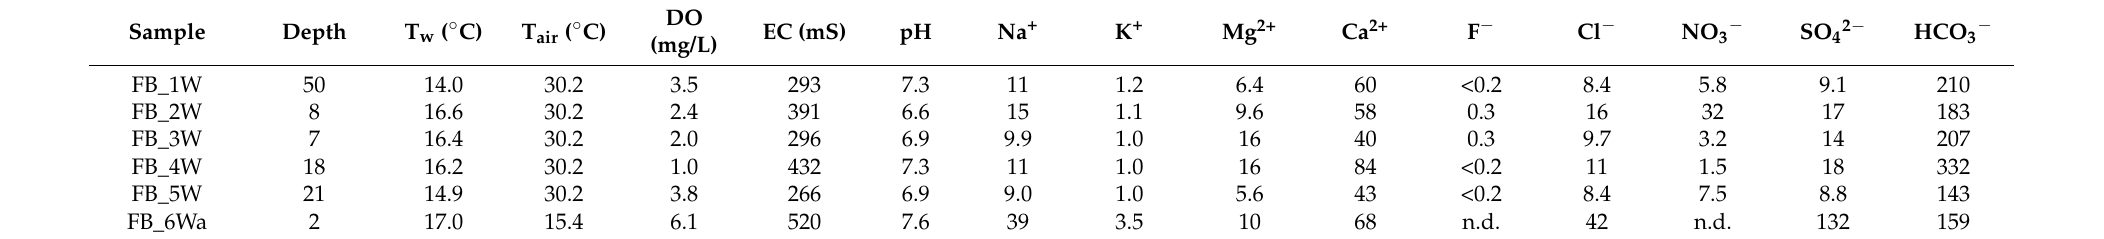
Table 3. The physico-chemical parameters and major ions chemistry (mg/L) measured on